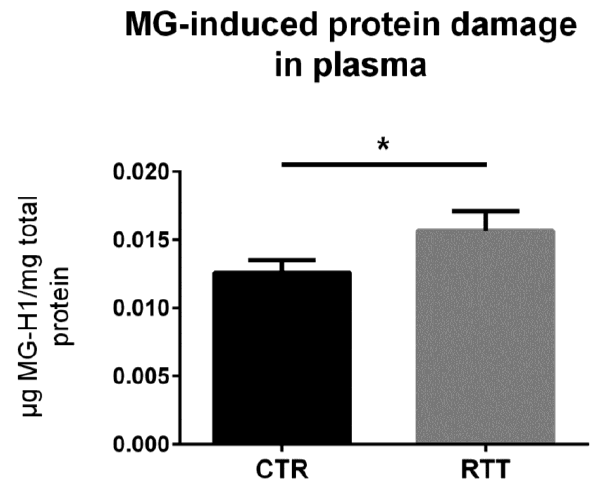
Figure 6. Assessment of dicarbonyl damage by the analysis of MG-H1 levels in plasma from RTT patients. Data were given as means ± SD. CTR, control; RTT, Rett syndrome. * p < 0.05. Data were analyzed by a t -test for independent groups.